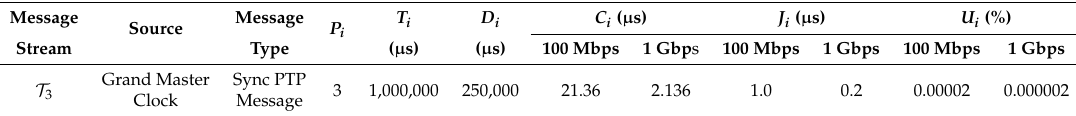
Table 10. Precision Time Protocol (PTP) message stream parameters for 100 Mbps and 1 Gbps Ethernet.